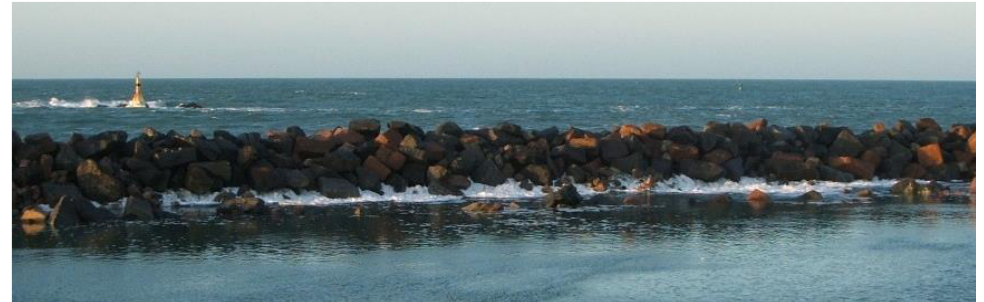
Figure 9. Wave transmission flow along core/armour interface (the author, January 2008). Figure 8. La Collette reclamation breakwater section, as model tested in 1993.